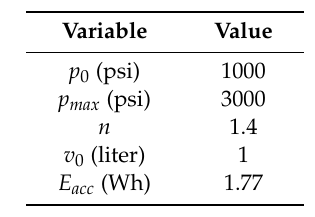
Table 7. Estimated energy capacity of the hydraulic